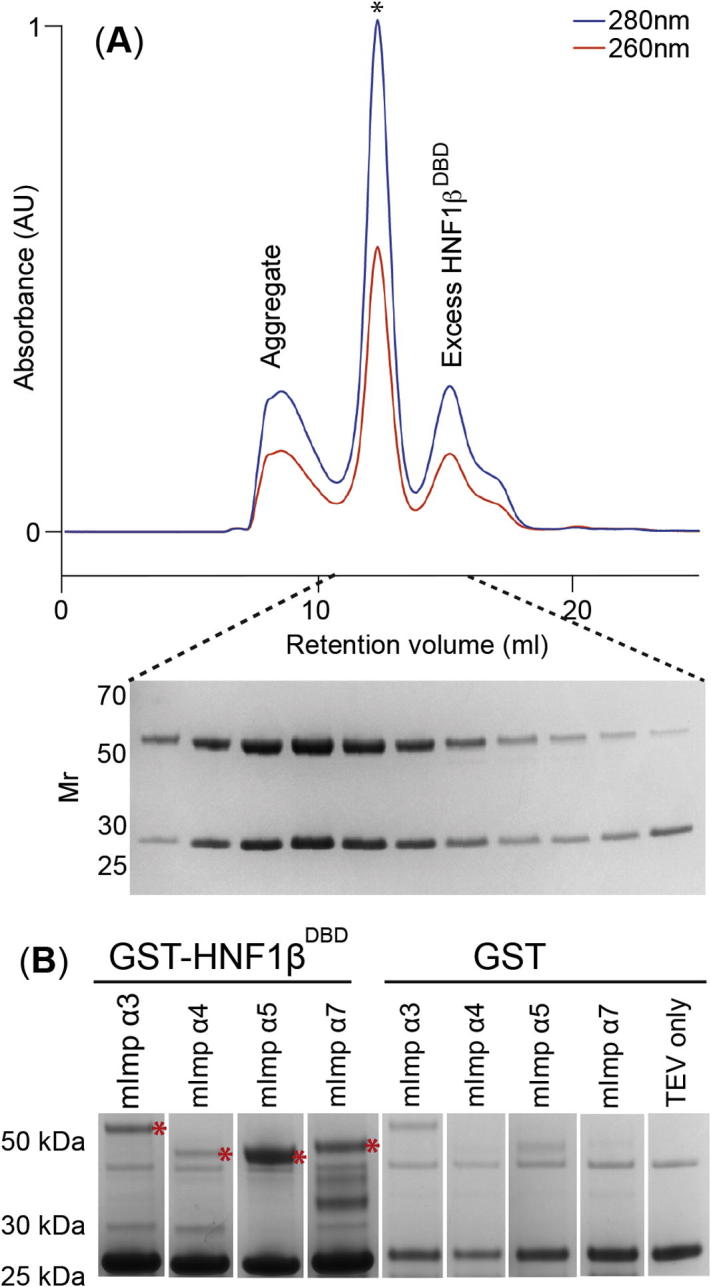
(A) Stable complex formation between ΔIBB mouse Importin-α1 (50 kDa) and HNF1β (27 kDa) during size exclusion chromatography. Fractions were analysed by Coomassie stained SDS-PAGE (∗ marks the peak for the complex); (B) GST pull-down with liberated HNF1β showing pull-downs using different ΔIBB mouse Importin-α isoforms (red ∗).